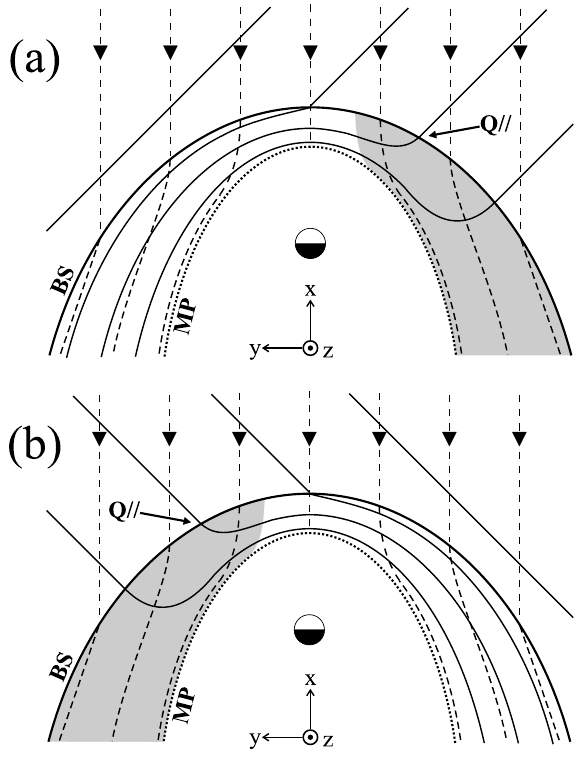
Fig. 4. The dawn-dusk asymmetry in the Fermi acceleration of ions at the bow shock shown in the GSM equatorial plane. Acceleration is seen on the dawn flank for (a) IMF B X /B Y < 0 (Parker spiral) and on the dusk flank for (b) IMF B X /B Y > 0 (ortho-Parker spiral) where the bow shock is “quasi-parallel” (i.e. B is parallel to the shock normal). BS - Bow Shock; MP - Magnetopause and Q || – quasi-parallel shock. Dashed lines with arrows are flow streamlines, solid lines are the interplanetary/magnetosheath magnetic field. In both (a) and (b), the IMF could be in either a toward (T) or away (A) orientation. The shaded region is where we would expect to see the shock accelerated